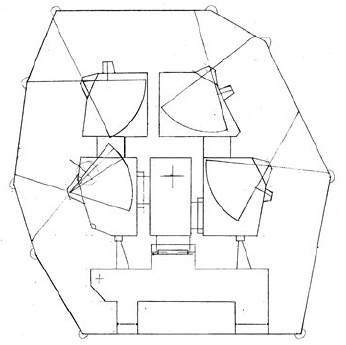
Figure 9. Image of artillery observation post № 453 with coded